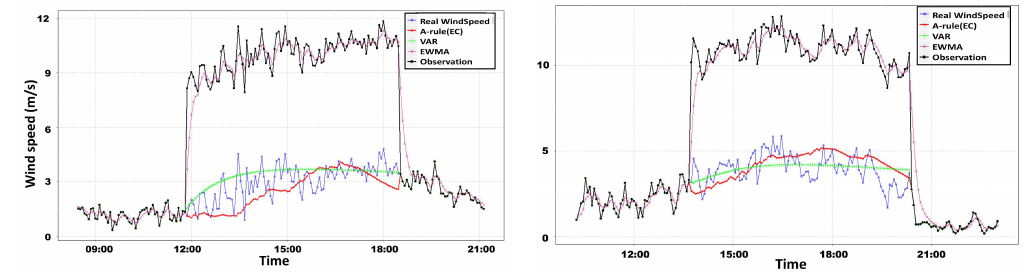
Figure 10. Detection and correction of synthetic faulty data from a wind speed sensor.